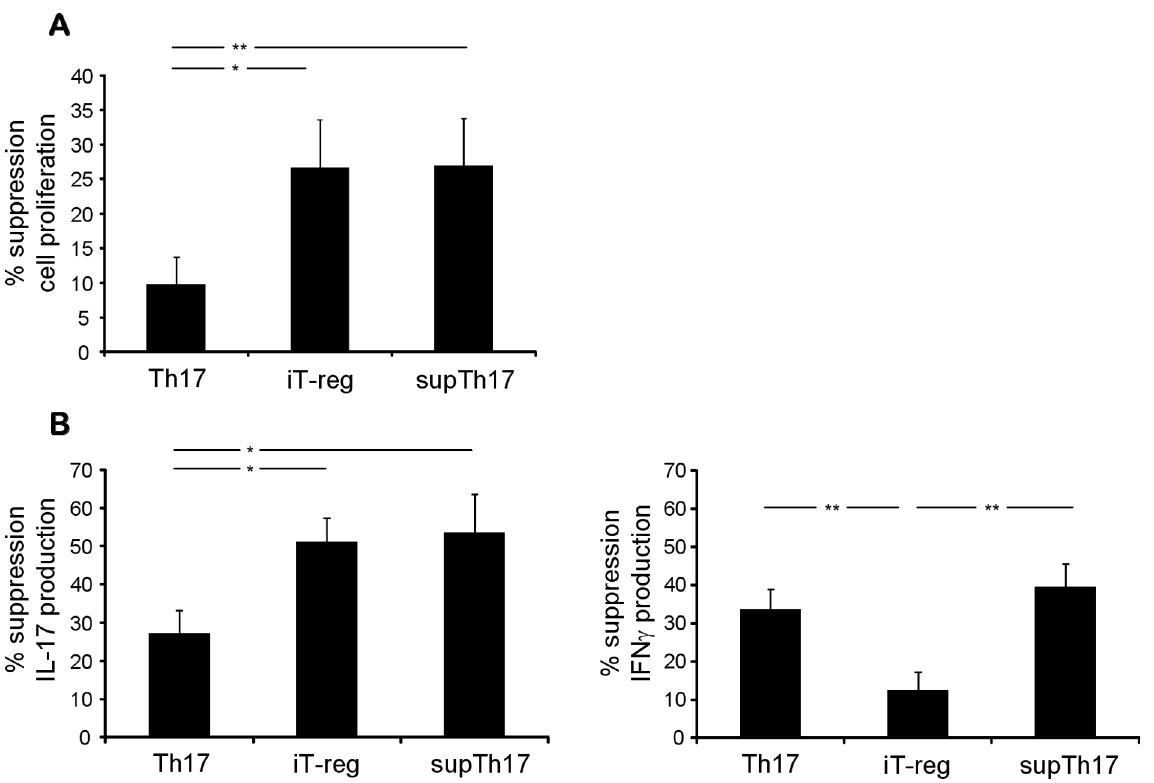
Figure 3. supTh17 suppressive ability. The ability of Th17, iT-reg and supTh17 cells to control CD4 target cell proliferation was evaluated after 4- day co-culture by 3 H-thymidine incorporation in 10 healthy subjects. (A) Mean ( + SEM) percentage inhibition of CD4 effector cell proliferation by Th17, iT-reg and supTh17 cells. (B) The ability of Th17, iT-reg and supTh17 cells to control CD4 target cell IL-17 and IFN c production was evaluated after 4- day co-culture by intracellular cytokine staining in 10 healthy subjects. Mean ( + SEM) percentage inhibition of CD4 effector cell IL-17 and IFN c production by Th17, iT-reg and supTh17 cells. Compared to prototypic Th17, supTh17 exerted more effective control over CD4 cell proliferation and pro-inflammatory cytokine production. * P # 0.05; ** P #